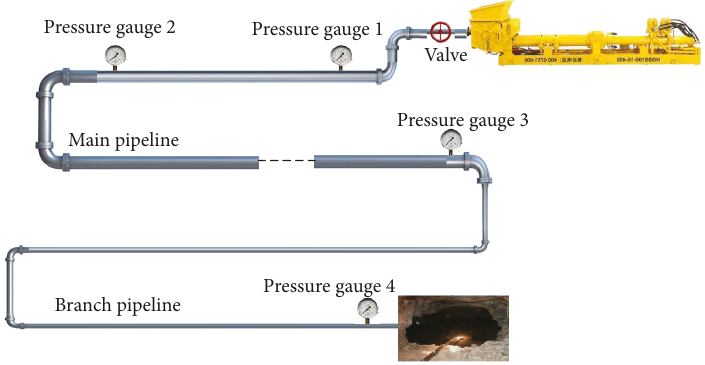
Figure 14: Back fi ll map of industrial experiment